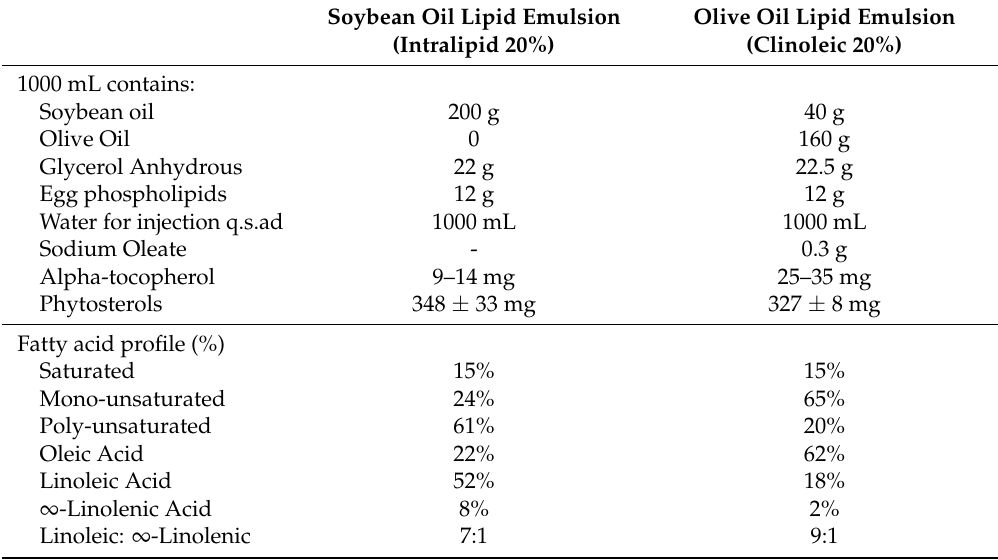
Table 1. Composition of lipid emulsions used in the